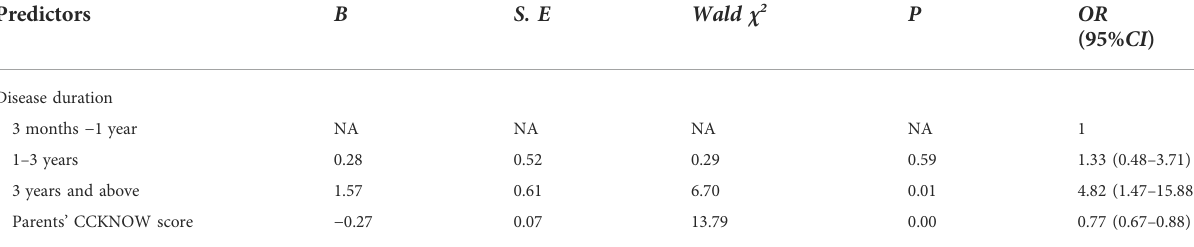
TABLE 6 Independent predictors for medication non-adherence in children with